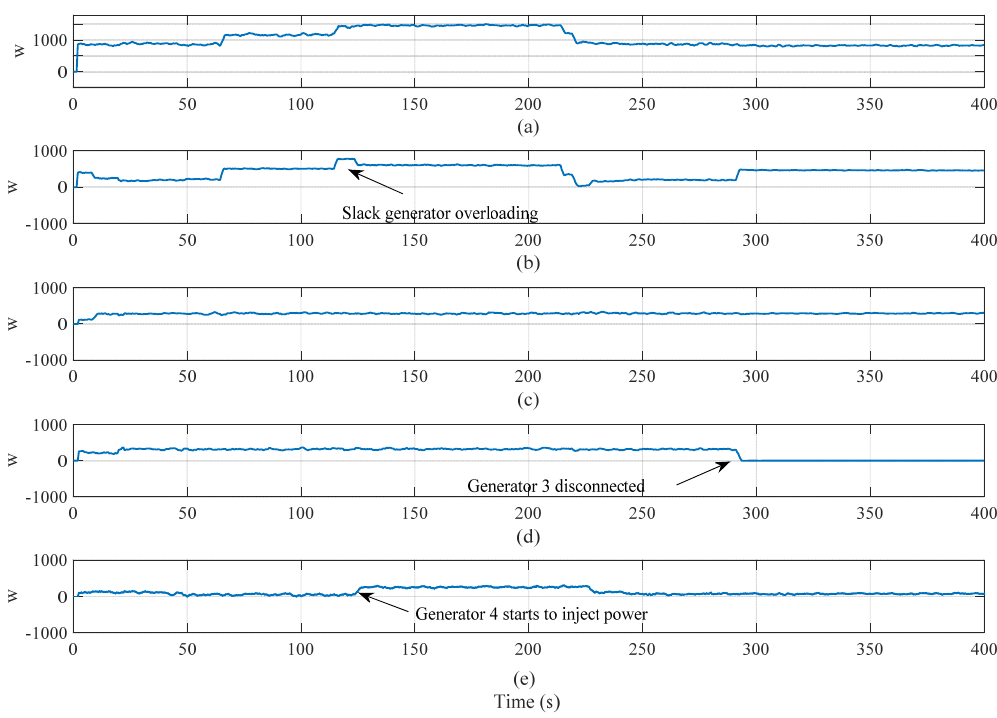
Figure 18. Case 2, load sharing. Power of ( a ) load; ( b ) generator 1; ( c ) generator 2; ( d ) generator 3; and ( e ) generator 4.